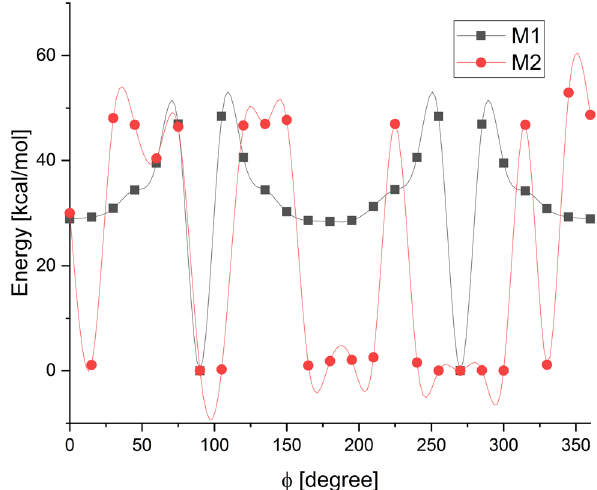
Figure 4: Calculated rotational energy barrier ( gas phase ) for M1 ( black trace ) and M2 ( red trace )